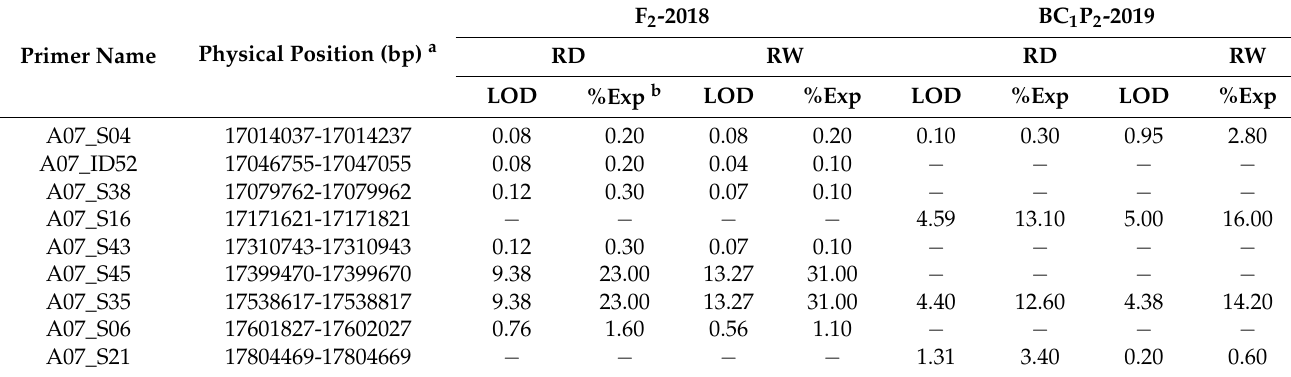
Table 2. QTL mapping analysis of the FR7.1 locus with the polymorphic markers.